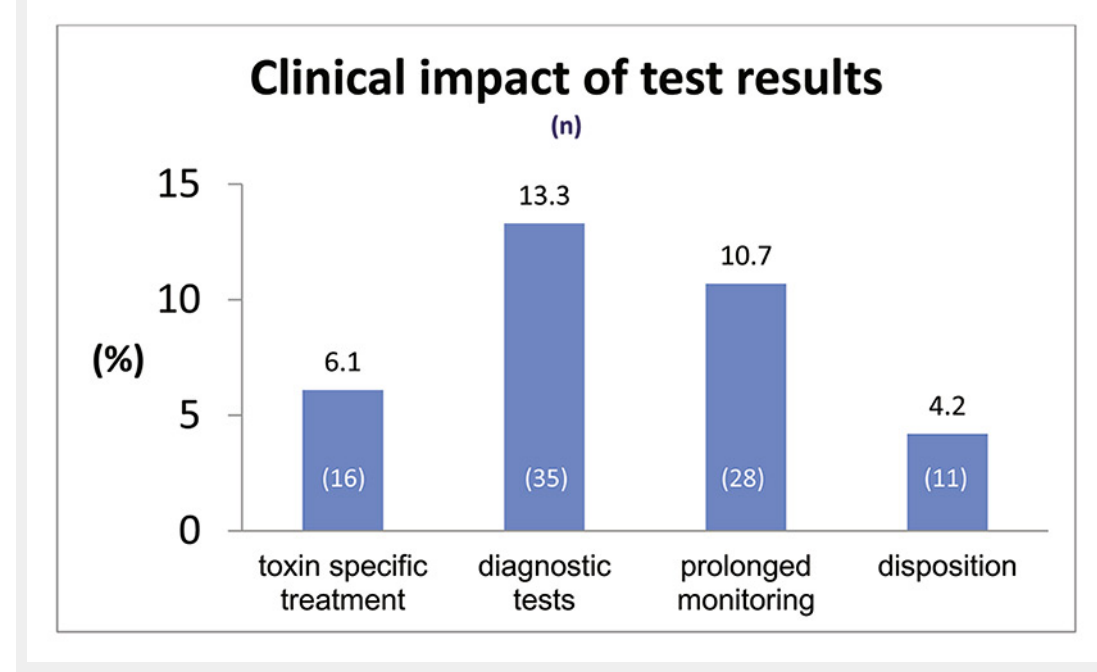
Figure 3 Impact of test results on clinical decisions (in %, n = 90) consecutive to the detection of substances with the Triage ® TOX drug screen (n = 262 tests). Toxin-specific administration of naloxone, flumazenil or N-acetycysteine or other drug-specific treatments after test results. Diagnostic tests = drug-related diagnostic tests ordered after test result; disposition = psychiatry transfer influenced by negative screening / somatic transfer if positive; prolonged monitoring = longer monitoring when methadone